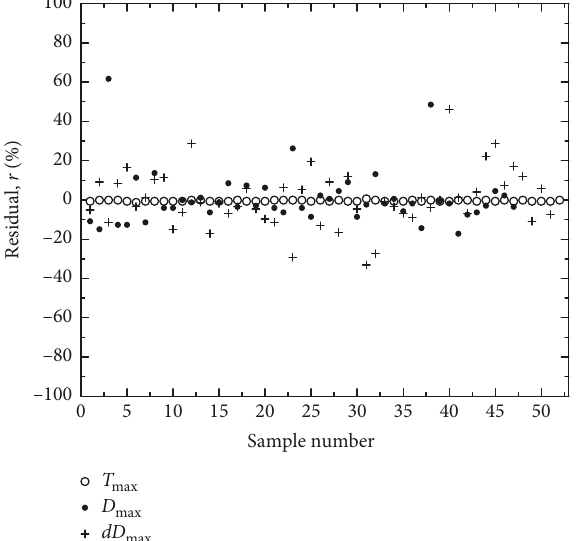
Figure 16: Residual for all the samples based on the response surface